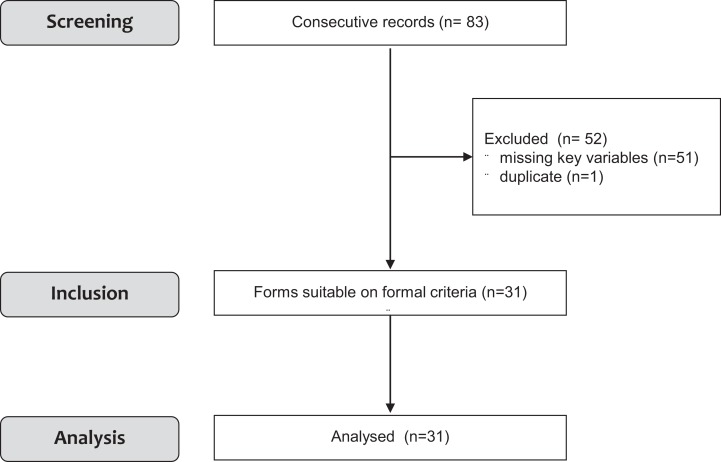
Flowchart of the study.